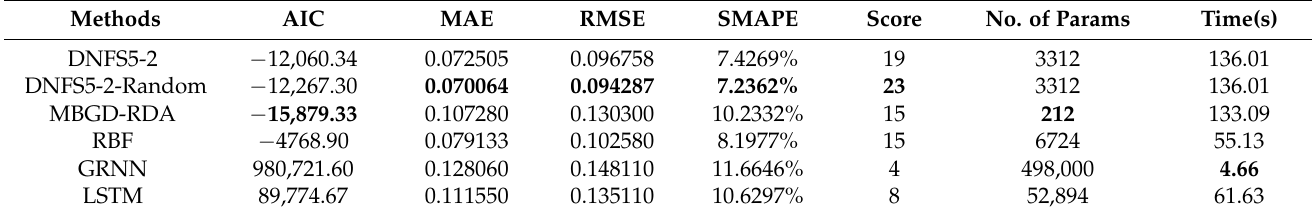
Table 10. The performance of different algorithms on Test Dataset No. 3.